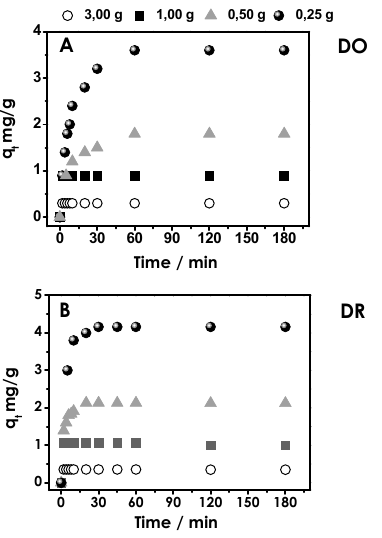
Figure 1. Effect of sieved Olive Pomace (OP P ) amount (gram for 40 mL of dye solutions) on the adsorption capacity q t (mg·g − 1 ) for Direct Orange (DO) ( A ) and Direct Red (DR) ( B ) dyes removal from aqueous/acetic acid (5 × 10 − 5 M) solutions, pH 3.5.